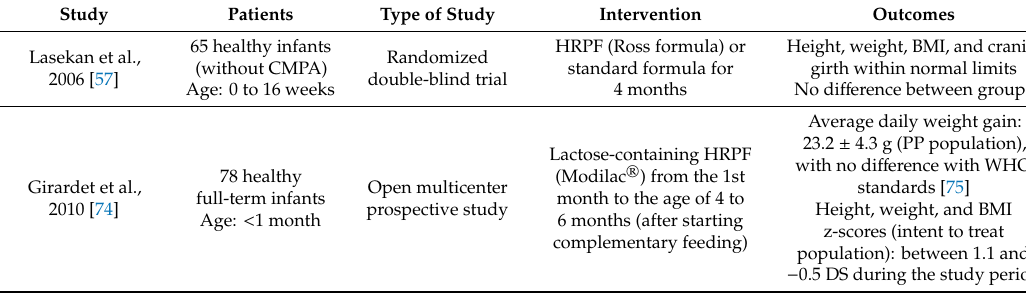
Table 4. Healthy infants fed with HPRF had a normal